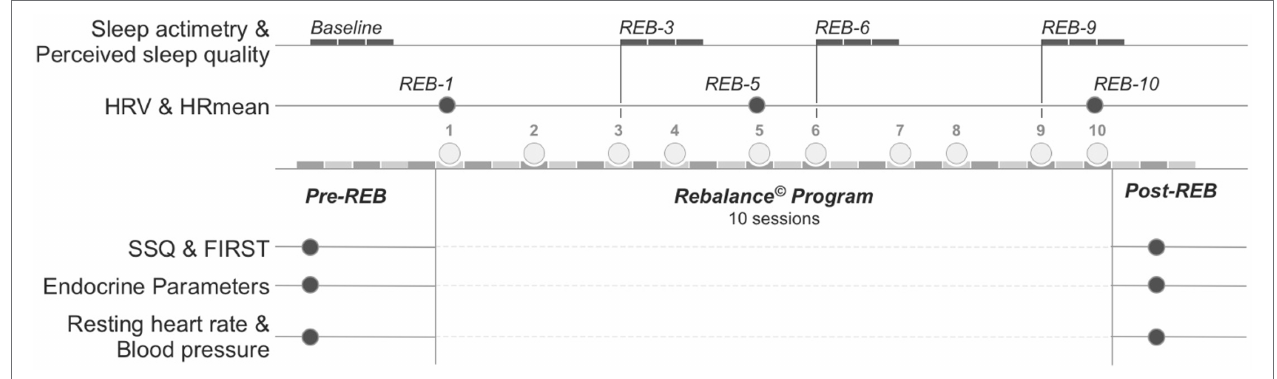
FIGURE 1 | Experimental design. Baseline, 3-day data collection period prior to Rebalance© session 1; REB-1 − 5, − 10, Rebalance© session number 1, 5, and 10, respectively; REB-3 − 6, − 9, 3-day data collection period following Rebalance© session number 3, 6, and 9, respectively; Pre-REB: prior to Rebalance© Program; Post-REB: following Rebalance© Program. HRV, heart rate variability; HRmean, average heart rate during HRV measurement; SSQ, Spiegel Sleep Quality questionnaire; FIRST, Ford Insomnia Response to Stress Test.